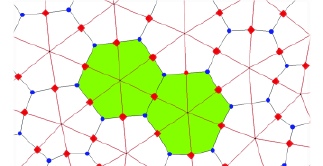
Fig. 2. Conversion of TETRA mesh to POLY mesh